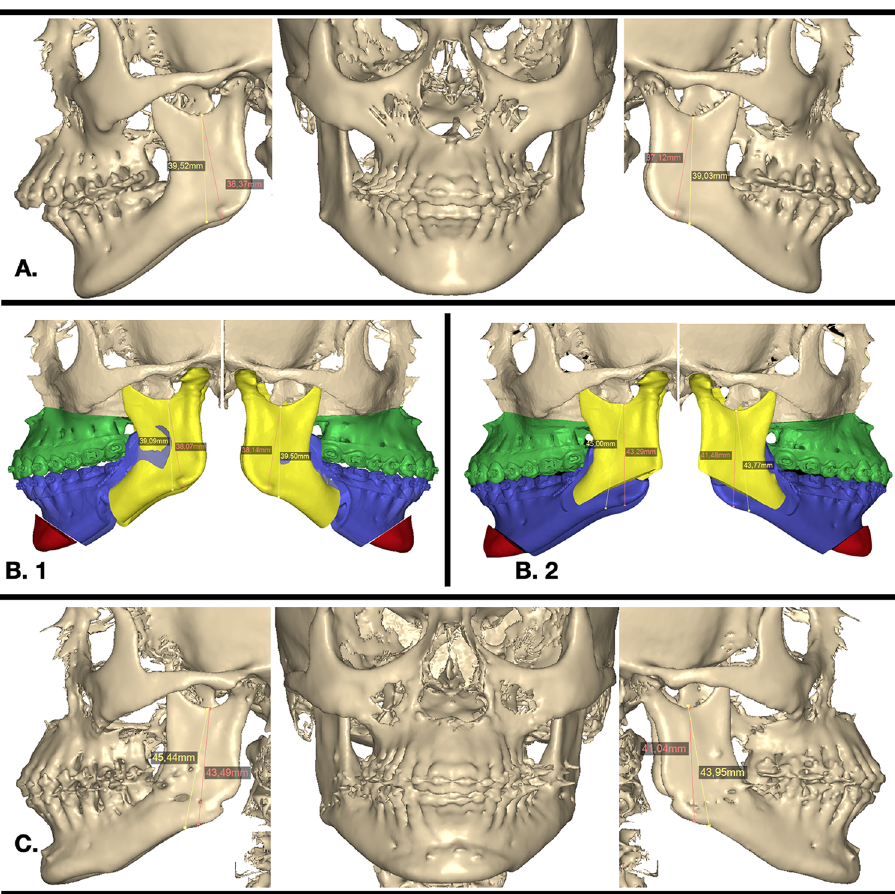
Fig. 4. 3D reconstruction; A. Before surgery, measure (R3 to the lowest border of jaw angle “ red ” , R3 to antegonial notch ” yellow ” ), B1. Surgical Planning without osteotomy modi fi cation (NemoStudio, NemoFAB, Version 2019), B2. Surgical Planning with BSSOM, C. Follow-up 1